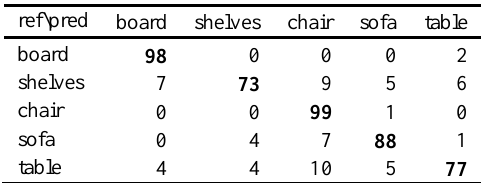
Table 5. Confusion matrix of CNN trained with point cloud images in the validation set.